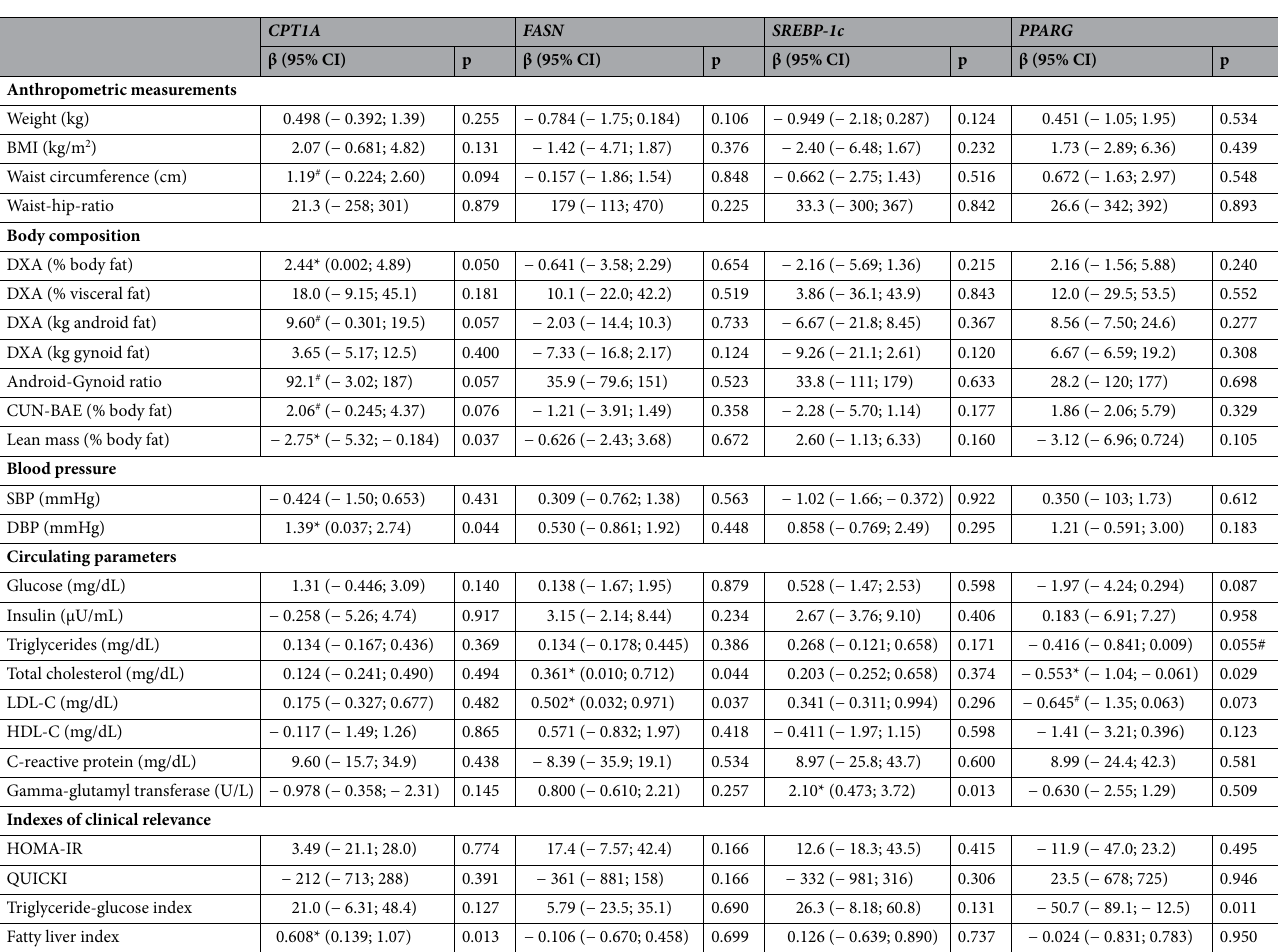
Table 6. Associations between concurrent 6-month weight loss-intervention (OW-OB, OW-OB-3M and OW-OB-6M groups) in gene expression levels (outcome variable) and anthropometric, clinical, and biochemical parameters (exposure variable), adjusted by age and sex. Analyses were performed using linear mixed-effects regression model with random intercept at visit and volunteer level. Beta represents